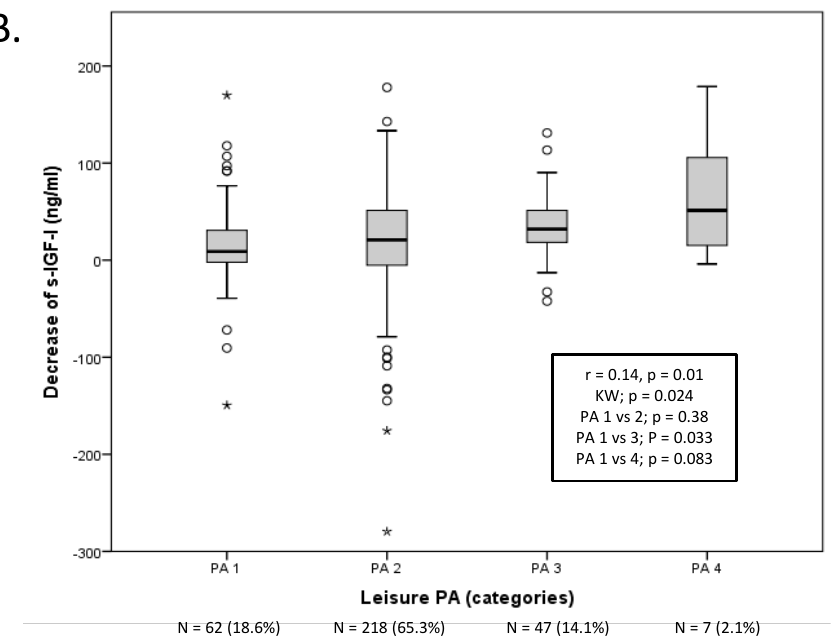
Figure 1. Serum insulin-like growth factor I insulin-like growth factor I (IGF-I) (ng / mL) according to pre-stroke physical activity (PA) levels 1-4, as assessed by Salting-Grimby. ( A ). Baseline IGF-I according to pre-stroke PA. ( B ). ∆ IGF-I, according to pre-stroke PA. ∆ IGF-I represents the change (decrease) in serum IGF-I (s-IGF-I) from baseline to 3 months post-stroke. Thus, a greater positive value in the figure represents a greater decrease. Box plots showing the median, interquartile ranges, whiskers, outliers (circles) and extremes (asterisks, see methods). The results of the Spearman correlation are given in the text box (rho, r , and p -values). The Kruskal–Wallis (KW) overall p -value is given as well as p -values for the Bonferroni-corrected (for 3 comparisons) comparisons vs. PA1. For baseline s-IGF-I, there were N = 363 (95.5%), and for ∆ IGF-I, there were N = 334 (87.8%), with numbers ( N ) and relative percentages (%) for each PA1–4 category given in the Figure.